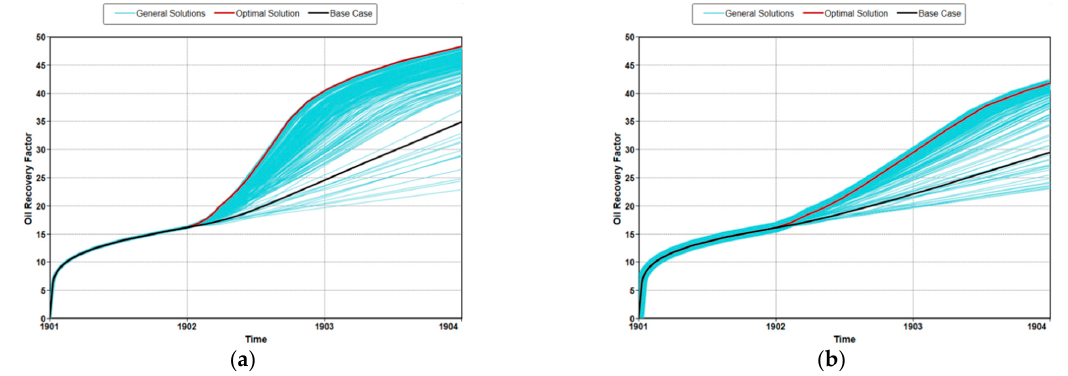
Figure 5. Optimization results for oil recovery: ( a ) ideal case and ( b ) real case.